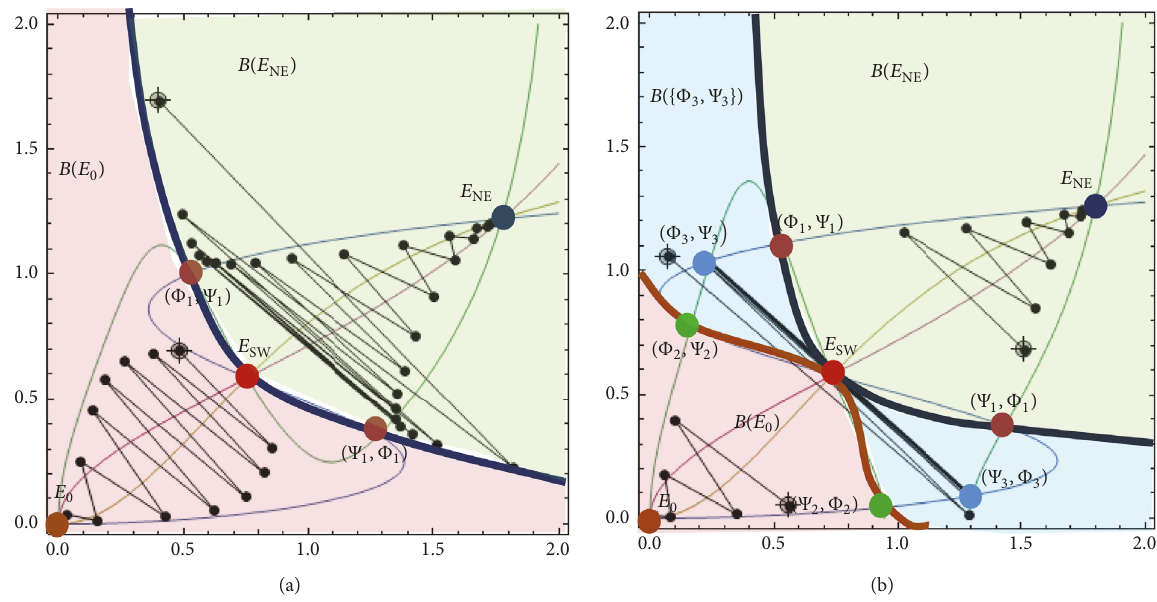
Figure 2: (a) Visual illustration of Theorem 34, case (e), where larger period-two solution is a saddle point. (b) Visual illustration of Theorem 34, case (e), where smaller period-two solution is a saddle